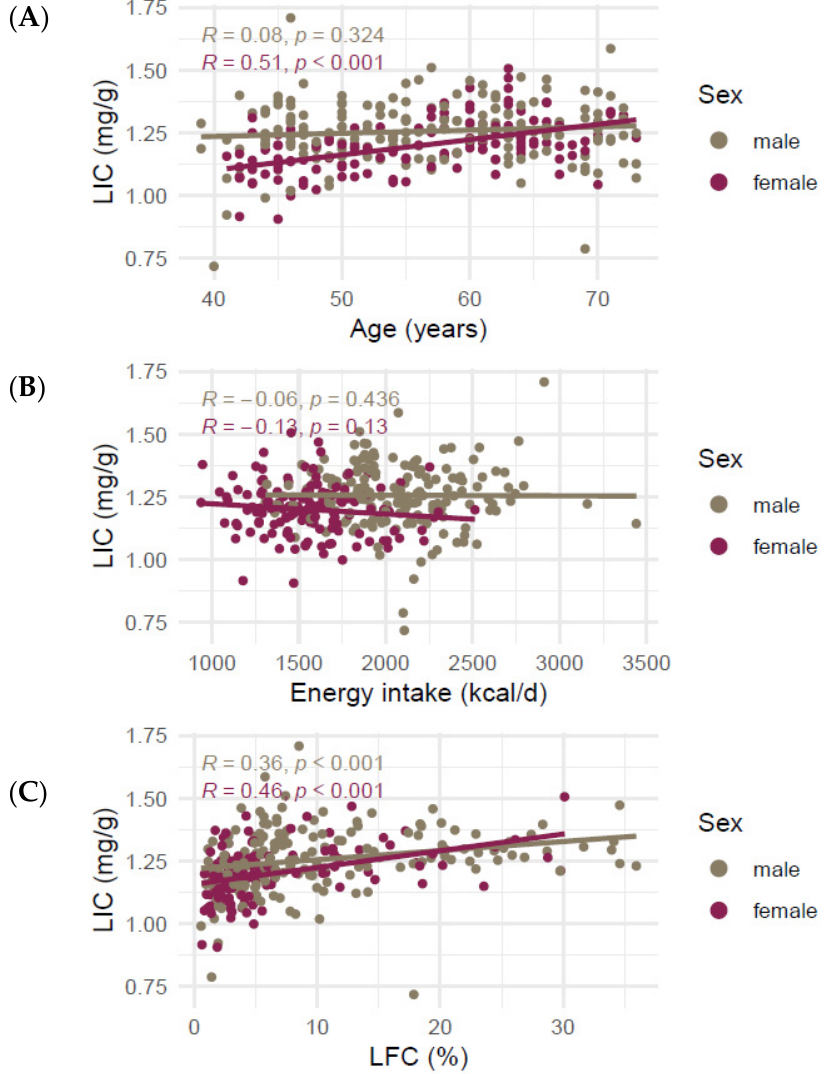
Figure 2. Correlation of liver iron content in mg/g and ( A ) age, ( B ) mean daily energy intake, and ( C ) liver fat. Lines represent lines of best fit in a univariate linear model. R denotes Spearman’s Rho. Abbreviations: LIC liver iron content, LFC liver fat content.